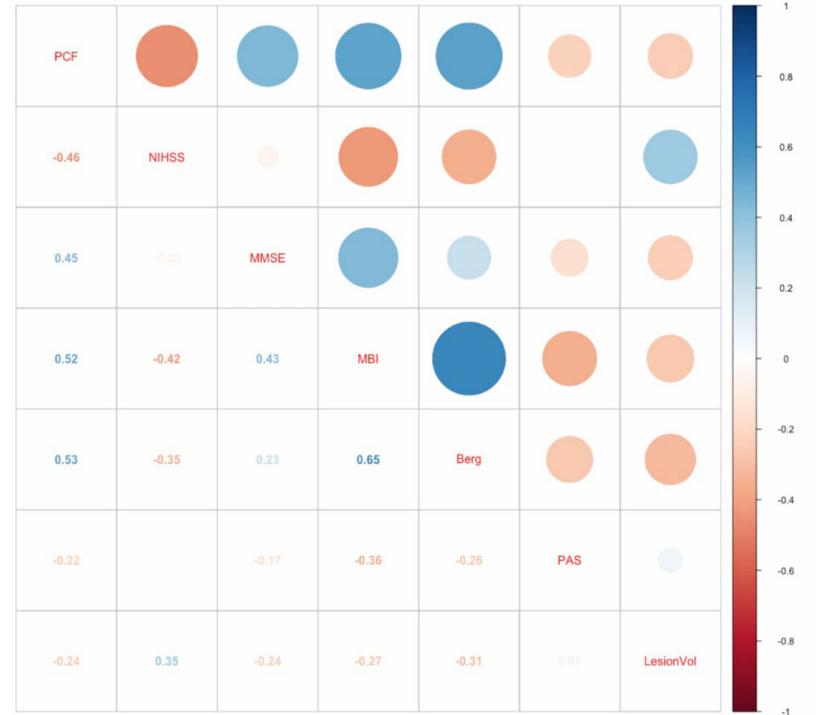
Figure 4. Heat map of correlation coe ffi cients (Spearman) between the lesion volume and functional parameters displayed in di ff erent colors. The color scale indicates the degree of correlation (blue, strong positive correlation; white, weak correlation; red, strong negative correlation). PCF: peak cough flow; NIHSS: National Institutes of Health Stroke Scale; MMSE: Mini-Mental State Examination; MBI: modified Barthel Index; PAS: Penetration Aspiration Scale; LesionVol: Lesion